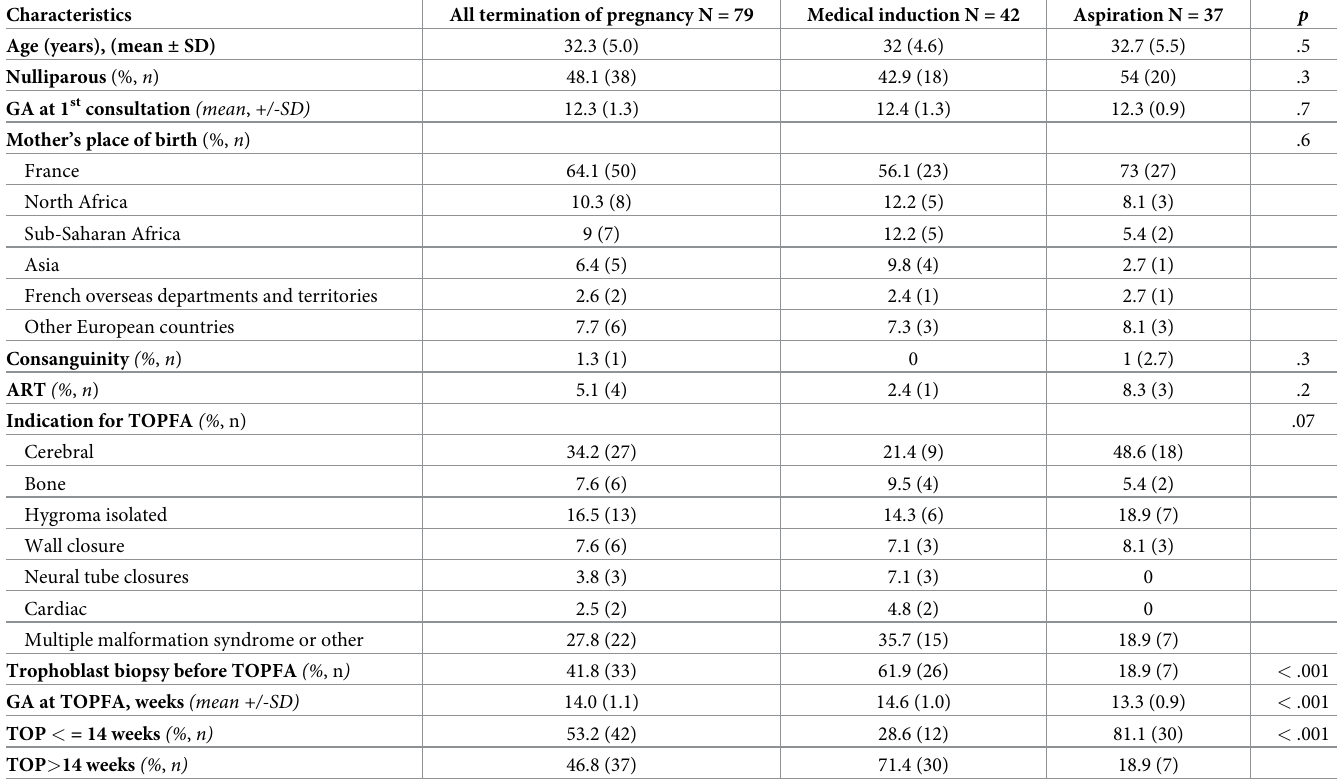
Table 1. Characteristics of the mothers and the terminations of pregnancy.